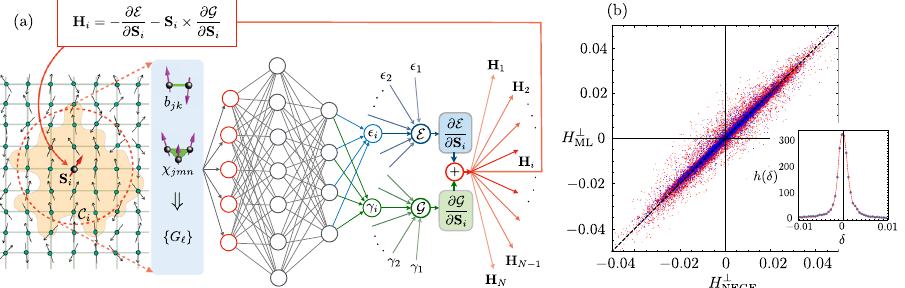
Fig. 2 A scalable neural-network force- fi eld model for out-of-equilibrium itinerant spin system and benchmark of force prediction. a Schematic diagram of the neural-network model . A descriptor transforms the neighborhood spin con fi guration C i to effective coordinates { G ℓ } which are then fed into a NN. The two output nodes of the NN correspond to the local energy ϵ i ¼ ε ðC i Þ and γ i ¼ χ ðC i Þ associated with site- i . The corresponding total potential energies E and G are obtained from summation of these local energies. Automatic differentiation 65,66 is employed to compute the derivatives ∂ E = ∂ S i and ∂ G = ∂ S i , from which the local exchange fi elds H i are obtained according to the generalized force expression Eq. (6). The NN model is trained by datasets obtained from nonequilibrium Green ’ s function (NEGF) calculation for a driven s-d model. Panel b shows the ML predicted forces versus those from the NEGF calculation for the s-d model with exchange coupling J = 3.8 t nn ; the blue and red data points correspond to the training and validation/test datasets, respectively. The inset shows the normalized distribution of the prediction error of the perpendicular components of the forces from the test dataset.